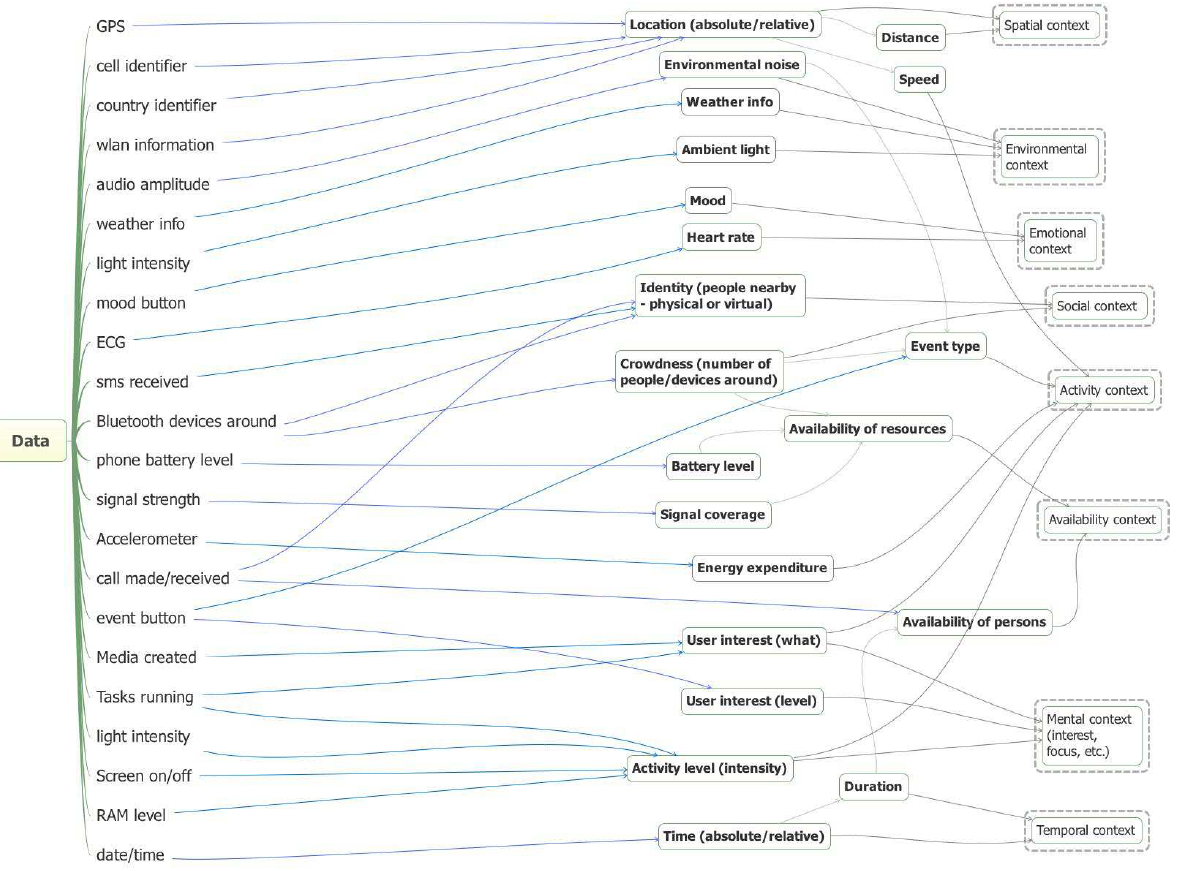
Figure 2 . Sensors supported by AIRS and types of processed